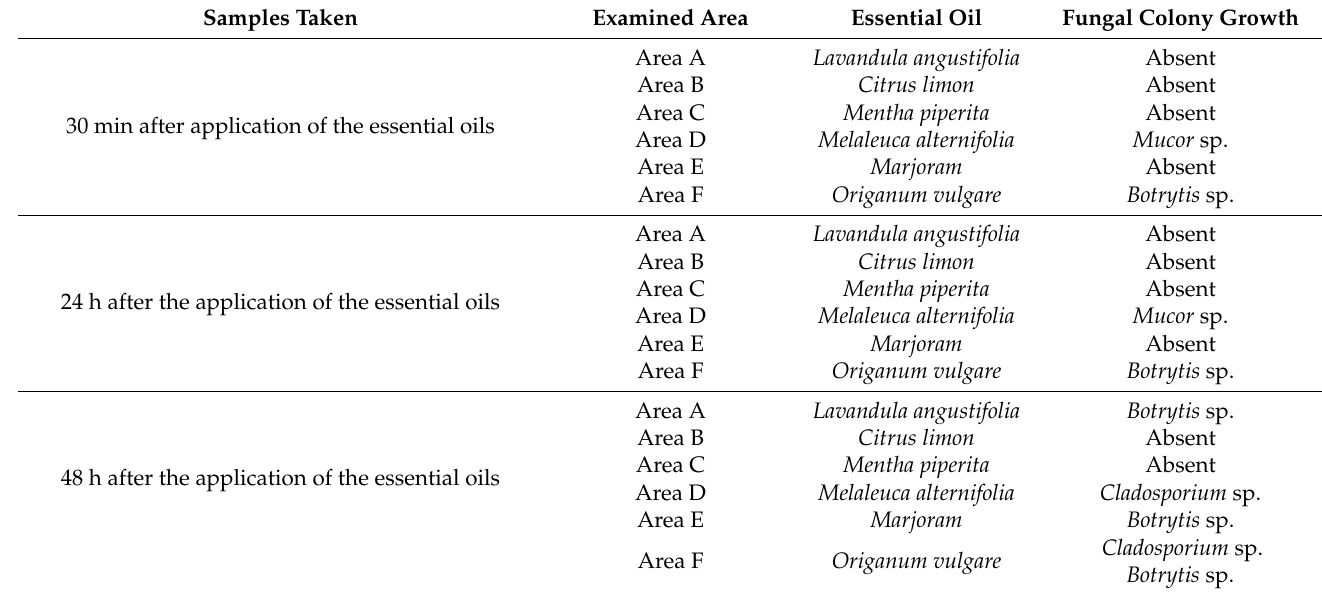
Table 3. Interpretation of the seeded plates, with samples taken 30 min, 24 h and 48 h after applying the essential oil. Samples Taken